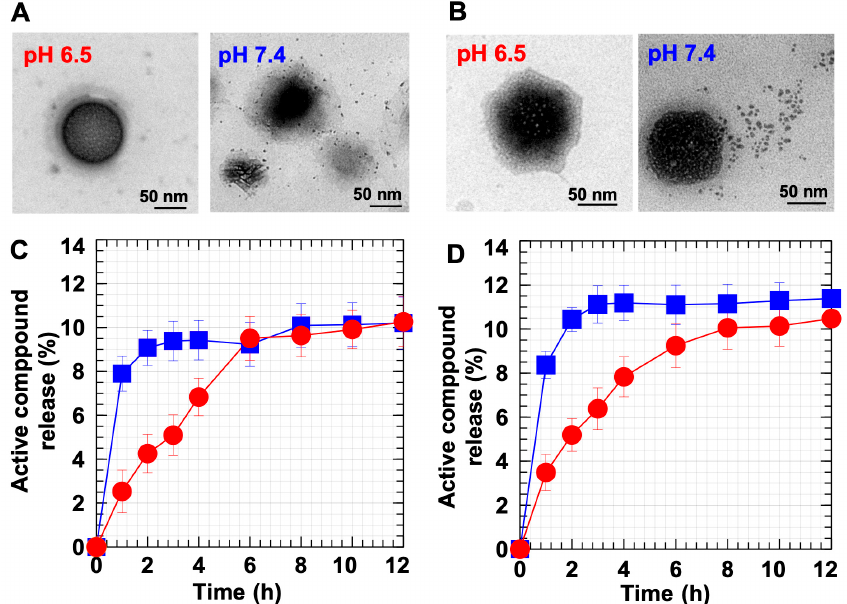
Figure 6. Controlled drug release behavior of DC-WCS-PG NPs in PBS buffer at different pHs. Representative TEM images of ( A ) PTX and ( B ) BBR releasing from DC-WCS-PG NPs in pH 6.5 and pH 7.4 buffer solution at 1 h. Kinetics release profile of ( C ) PTX and ( D ) BBR from DC-WCS-PG NPs in PBS buffer at pHs of 6.5 ( ) and 7.4 ( ).